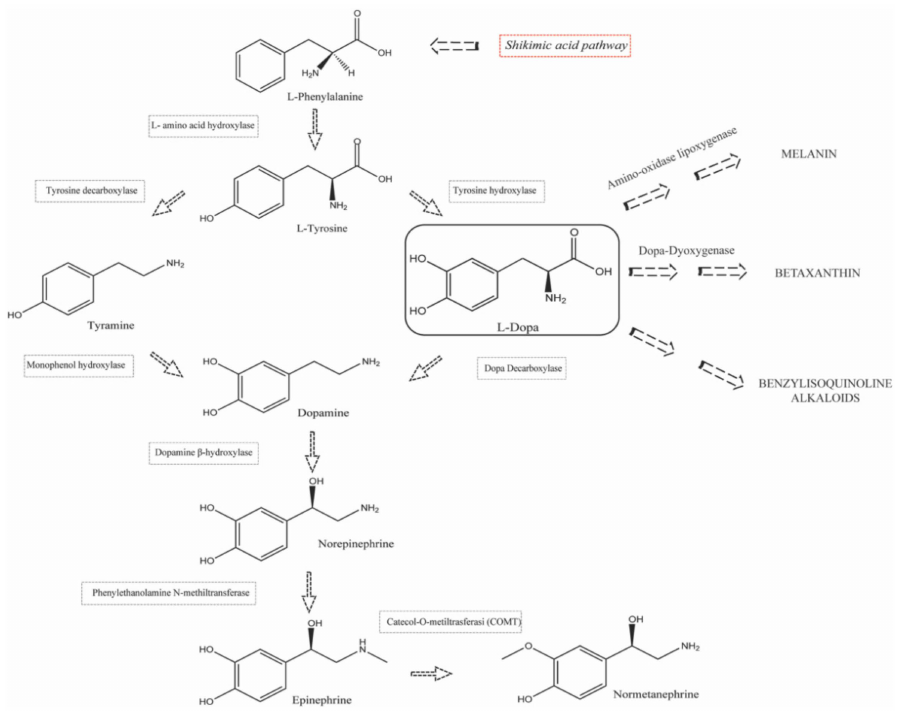
Figure 4. Plant catecholamine synthesis